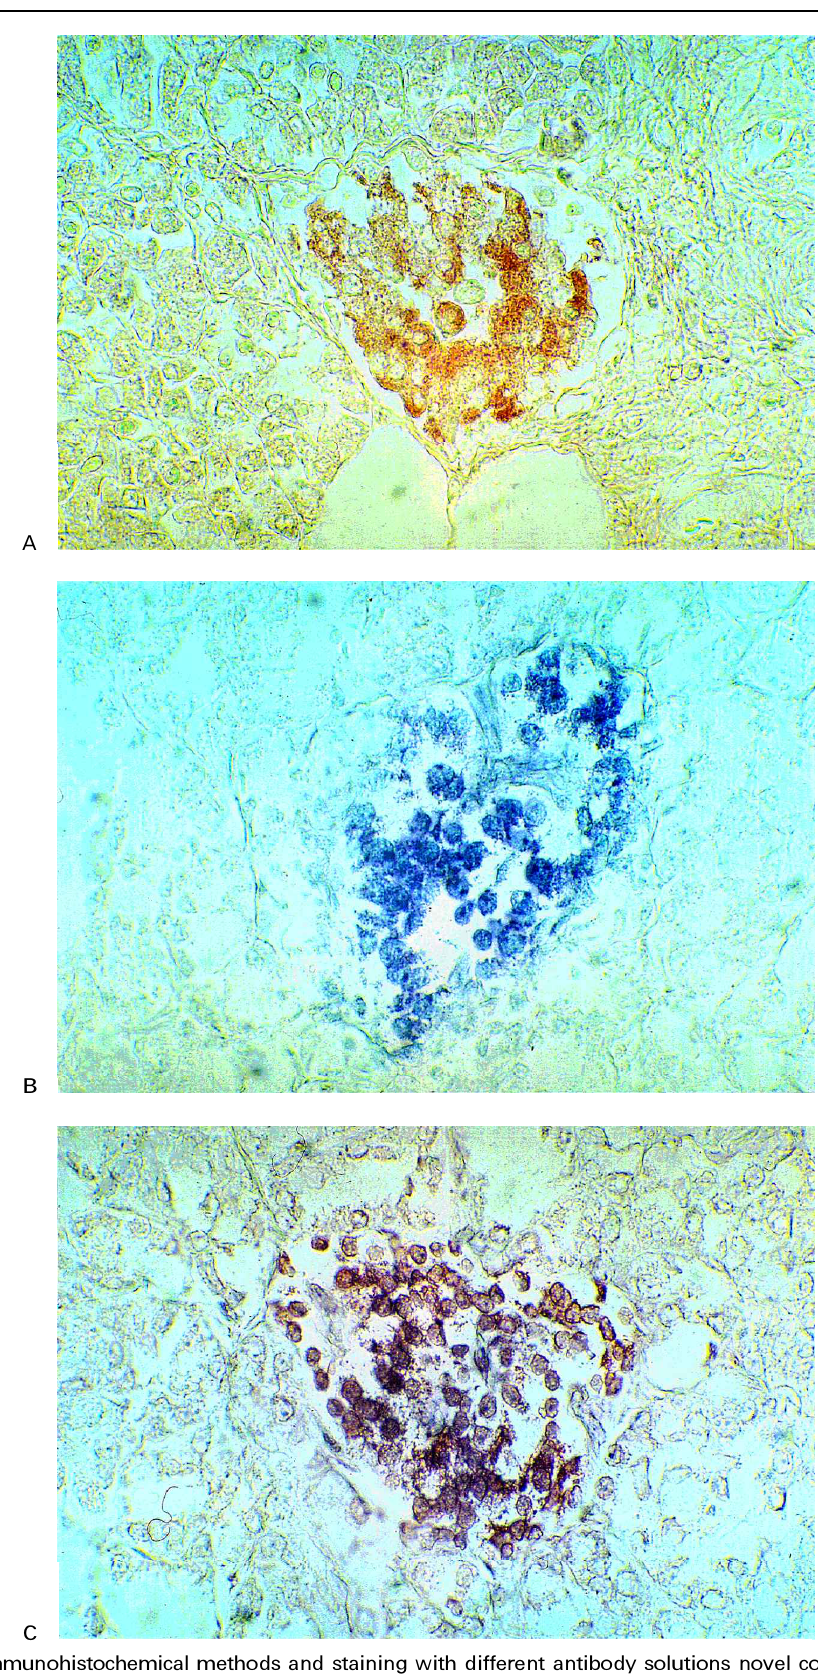
FIG. 2. Using immunohistochemical methods and staining with different antibody solutions novel colour schemes can be accomplished. (A) The presence of immunoreactive SLPI was demonstrated using a specific human anti-SLPI antibody resulting in a bright red colour in the islets of Langerhans. (B) Human anti-insulin antibodies showed blue staining in the b -cells of pancreas tissue. (C) Staining the specimens first for insulin then for SLPI resulted in a purple colour indicating the presence of insulin and SLPI in the b -ceIls of the islets of